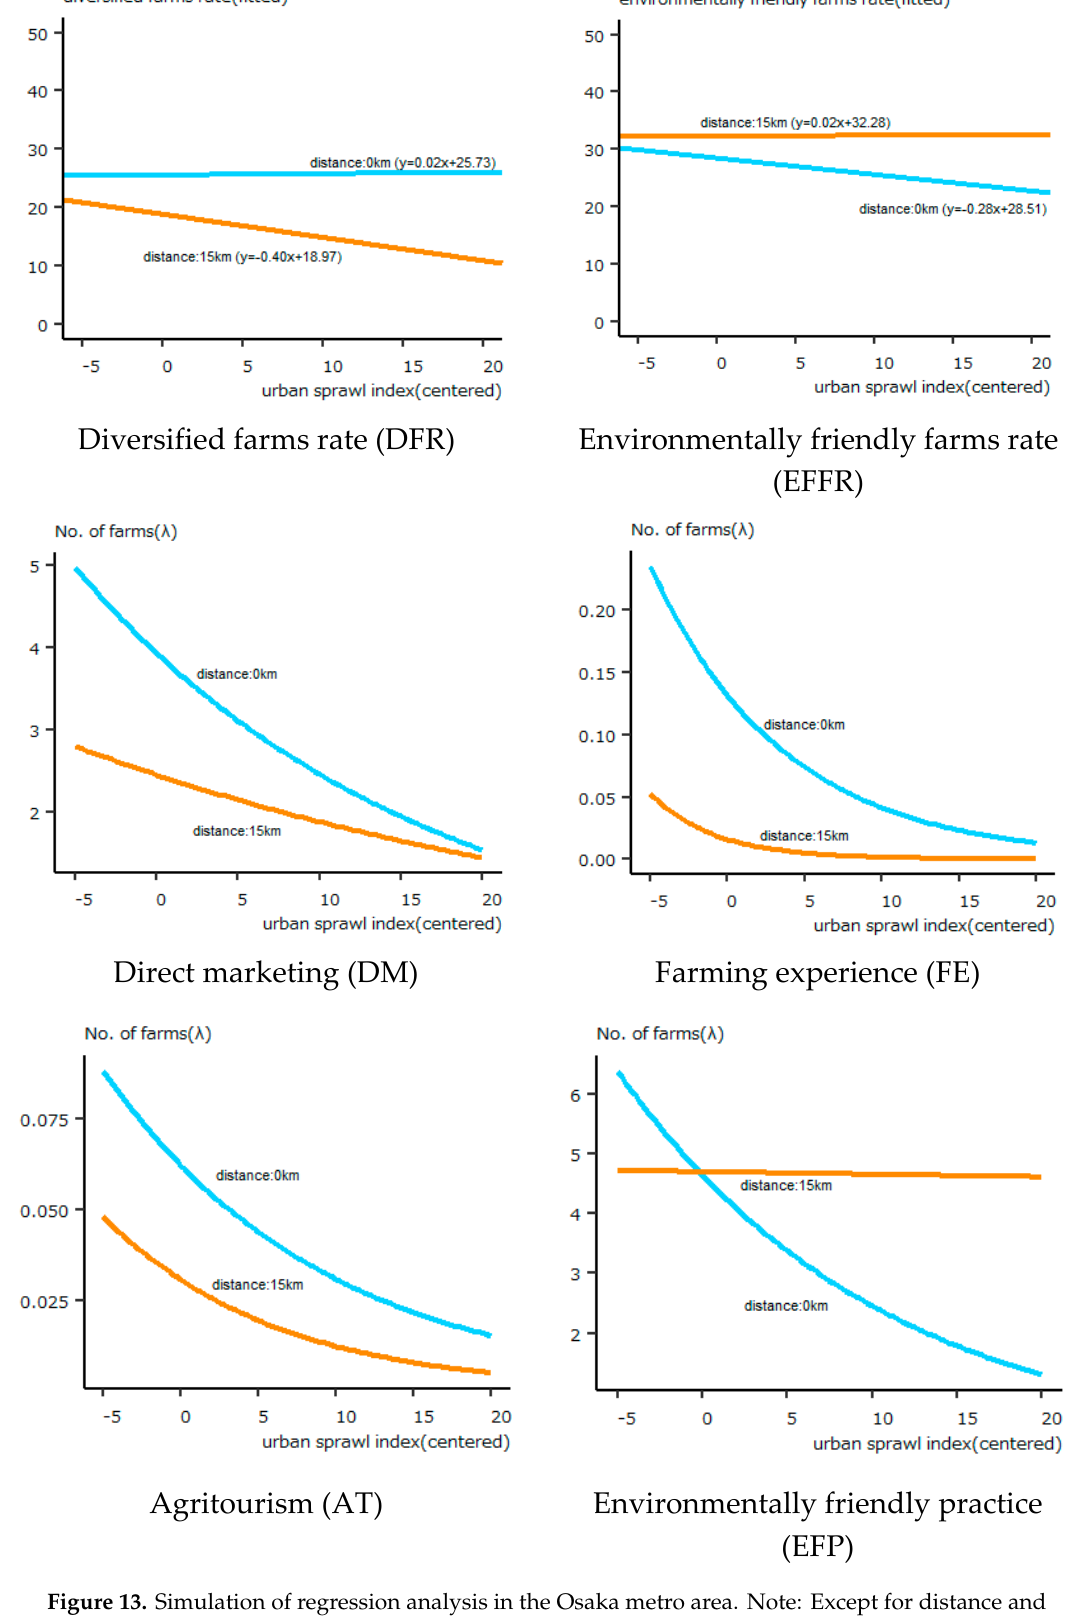
Figure 13. Simulation of regression analysis in the Osaka metro area. Note: Except for distance and sprawl index, the average values of all variables were substituted in the estimated equation.